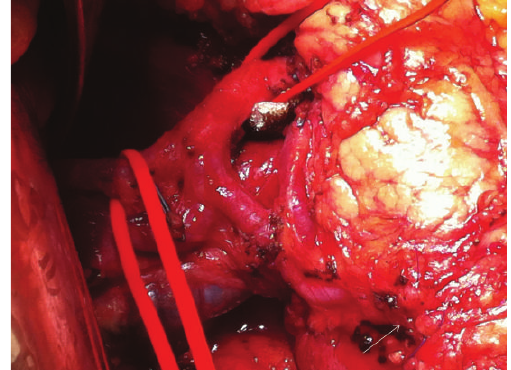
Figure 1: During initial laparotomy, the lateral aspect of the surgical bed after completion of bursectomy and the closed ultralow duodenal stump (arrow) can be seen.